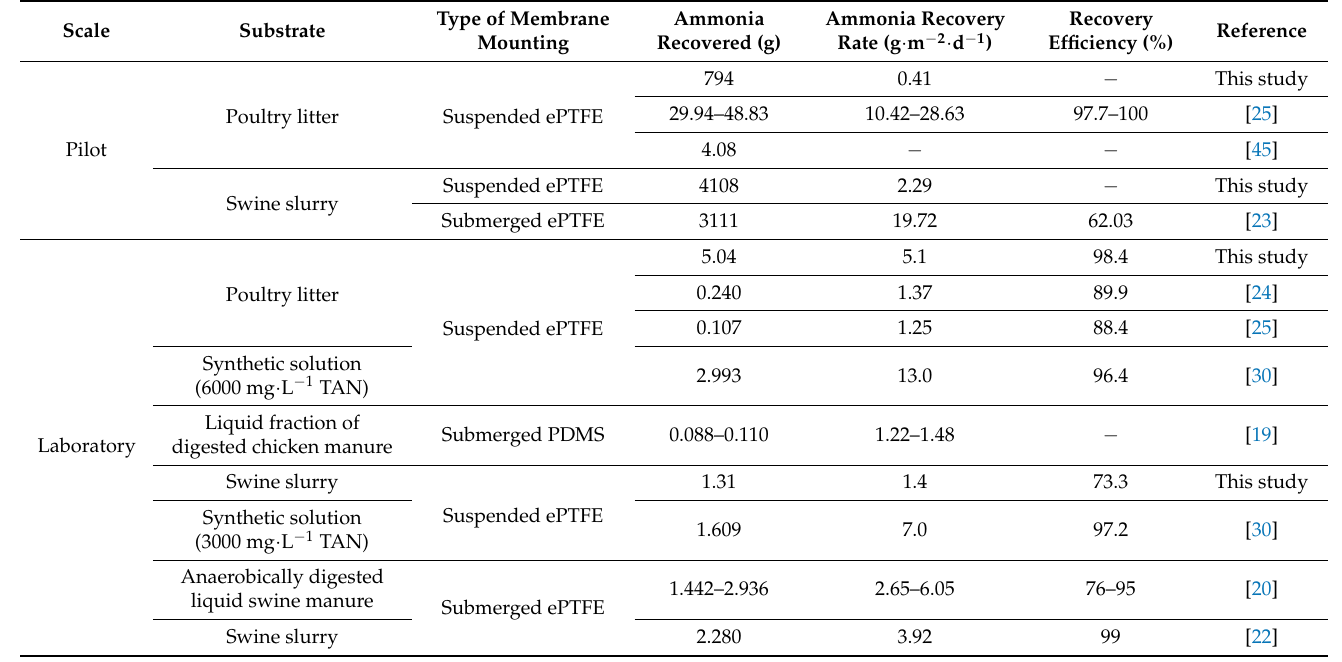
Table 4. Comparison of results attained in pilot scale and laboratory scale reported in the